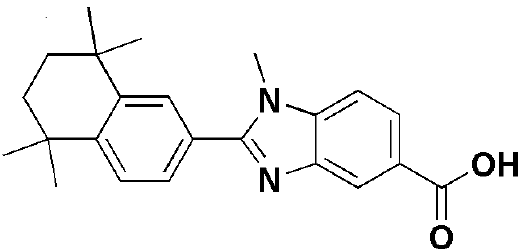
Figure 1. 1-methyl-2-(5,5,8,8-tetramethyl-5,6,7,8-tetrahydro-naphthalen-2-yl)-1H-benzoimidazole- 5-carboxylic acid, a retinoid derivative showing MIC value of 50 μg/mL against Candida krusei and Candida albicans. This sketch was drawn in ChemDraw ® Ultra 7.0. Perkin Elmer Italia